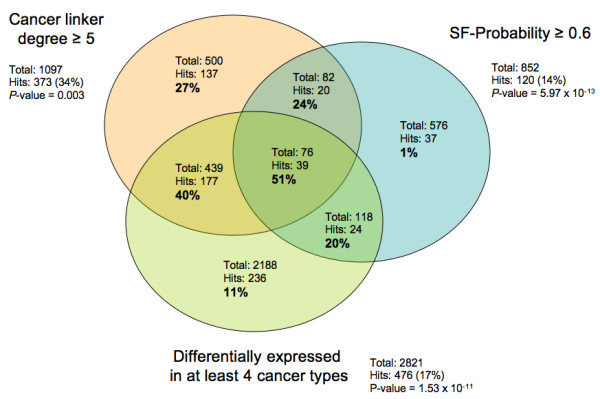
Positive predictive value calculated for diverse overlaps of cancer gene candidates. The criteria applied was the following: (i) cancer linker degree ≥ 5; (ii) differentially expressed in at least four cancer types; and (iii) SF-Probability ≥ 0.6. The Venn diagram shows the total number of candidates, the number of hits (i.e. known cancer genes among the candidates) and the positive predictive value for overlap case. For example, the positive predictive value when solely applying an SF-Probability threshold of 0.6 was 14%. In contrast, when combining the SF-Probability with a cancer linker degree threshold of 5, the positive predictive value was 37% (59 hits for a total of 158 candidates).